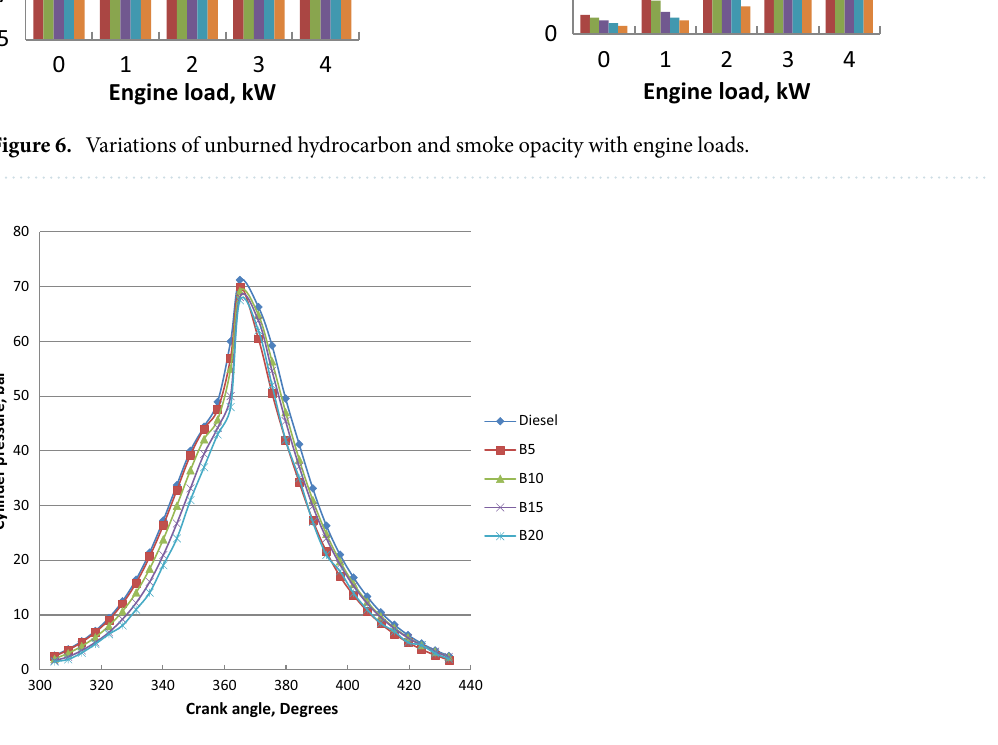
Figure 7. Cylinder pressure at different crank angles and full load for biodiesel